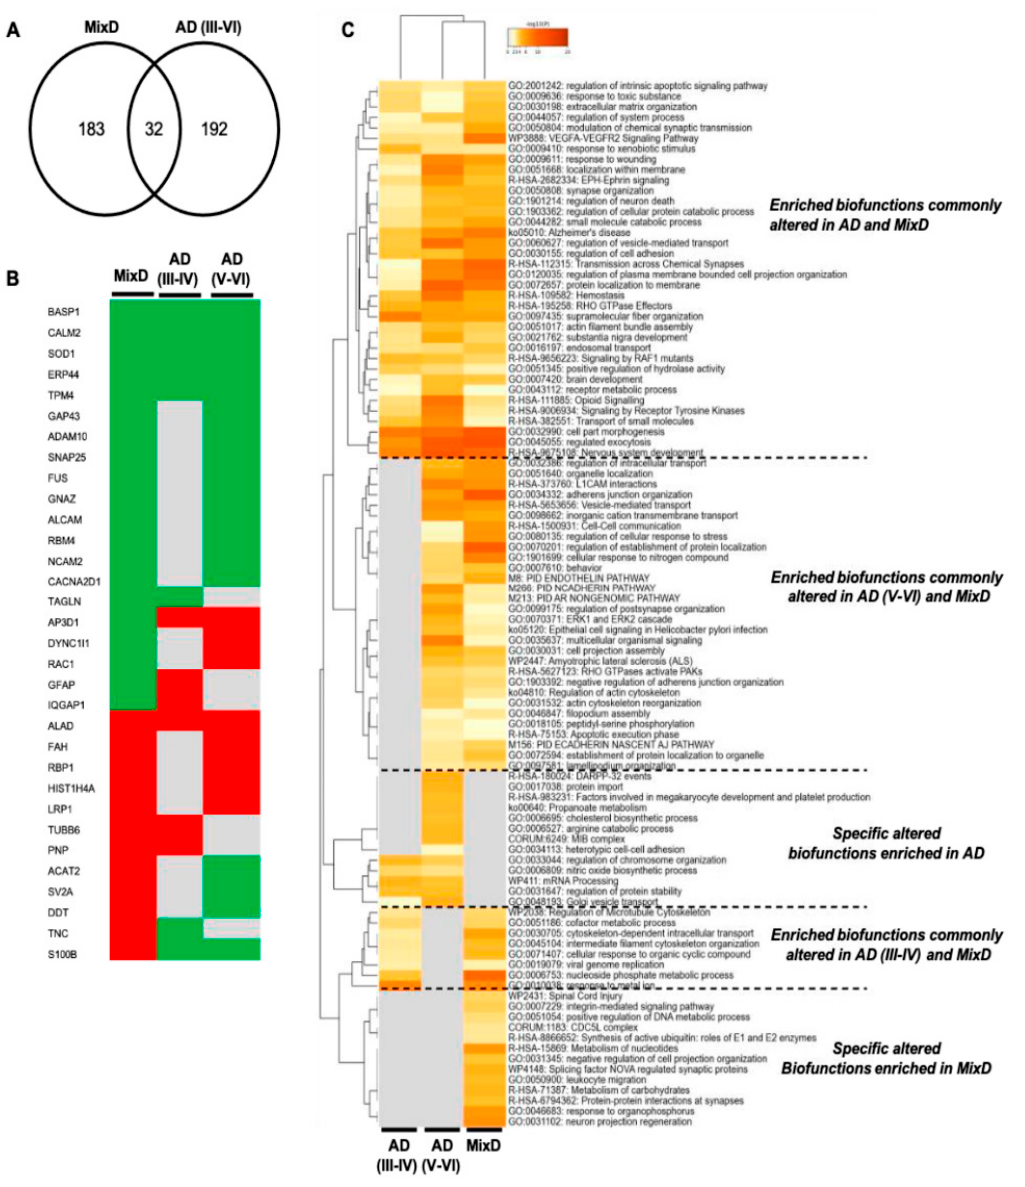
Figure 5. Comparative analysis between differential OB proteomes across AD and MixD. ( A ) Venn diagram showing the overlap od DEPs detected in AD (Braak stages III-VI) and MixD phenotypes. ( B ) OB Protein expression profile of the 32 common deregulated proteins between AD and MixD (green: downregulated; red: upregulated; grey: not differentially expressed). ( C ) Commonalities and differences observed in the significantly altered functional profile between AD and MixD phenotypes.